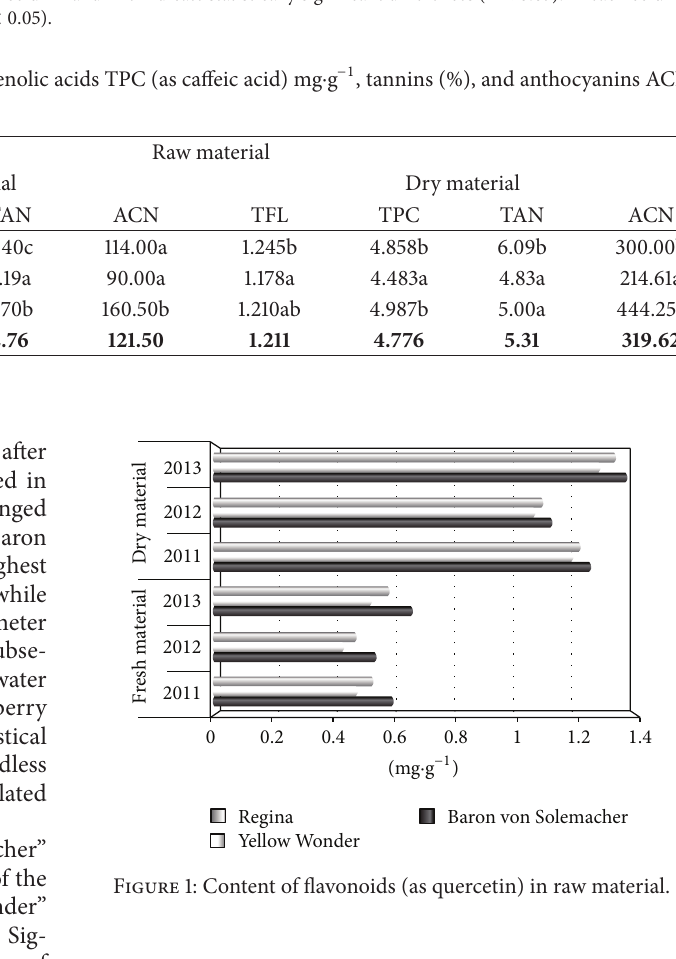
(0.471 and 1.178 mg ⋅ g −1 , resp., for raw and dried